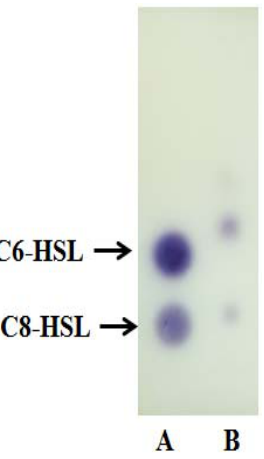
Figure 4. TLC analysis on C18-reverse phase TLC plates chromatographed in methanol/water (60:40, v/v) and visualized with C . violaceum CV026. Arrows indicate the positions of AHL standards run on the same plate. Lane A: C6-HSL (0.1 µg/µL) and C8-HSL (5 µg/µL). Lane B: Extract of the spent culture supernatant of A9.